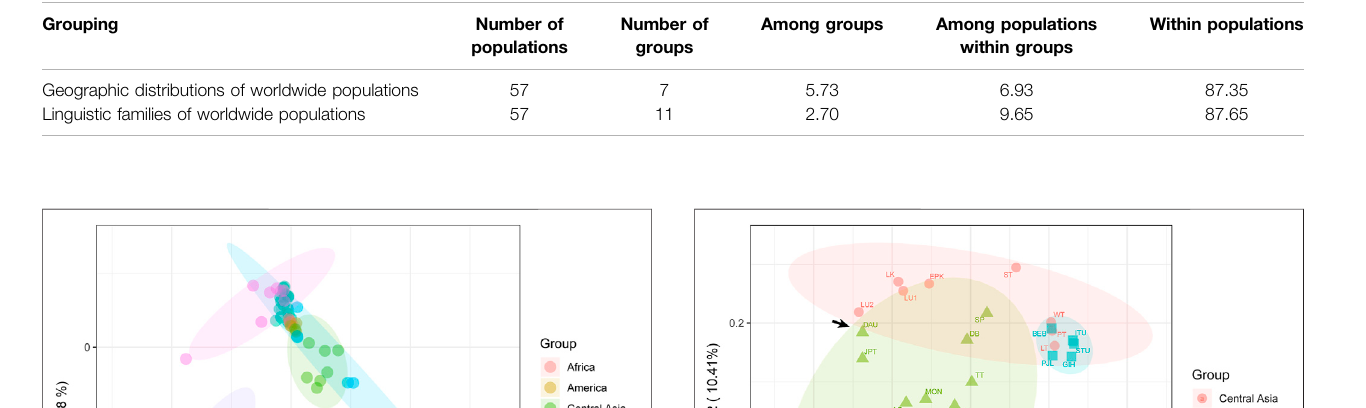
TABLE 3 | The AMOVA results based on 57 worldwide populations.